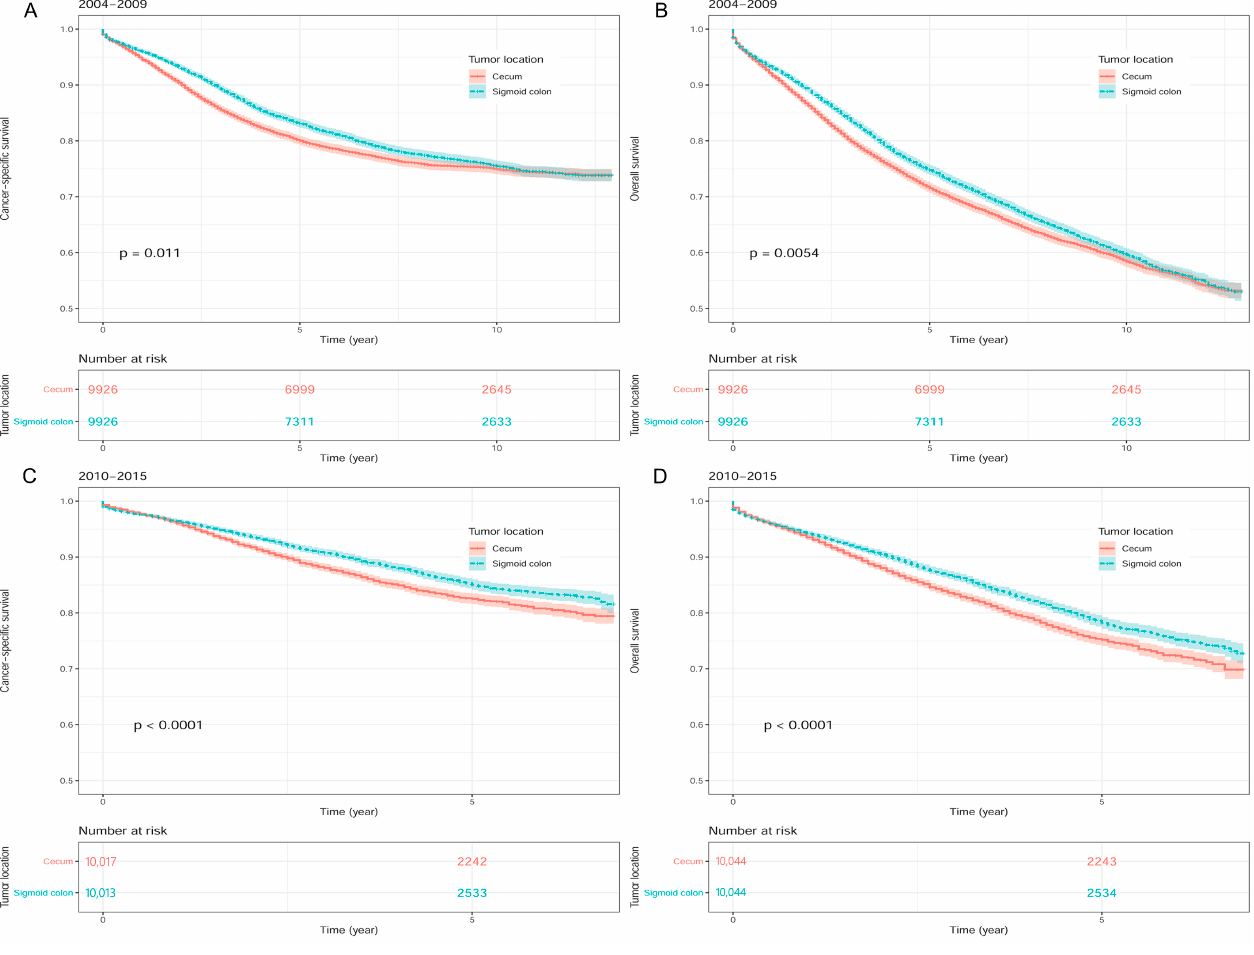
Figure 4. Kaplan-Meier survival curves between sigmoid colon cancer and cecum cancer after propensity score matching in SEER database. ( A ) Cancer-specific survival in 2004–2009. ( B ) Overall survival in 2004–2009. ( C ) Cancer-specific survival in 2010–2015. ( D ) Overall survival in 2010–2015. Footnotes: S EER , the Surveillance, Epidemiology, and End Results. Table 4. Univariate Cox regression analysis of prognostic factors after propensity score matching for patients diagnosed with cecum or sigmoid cancer.